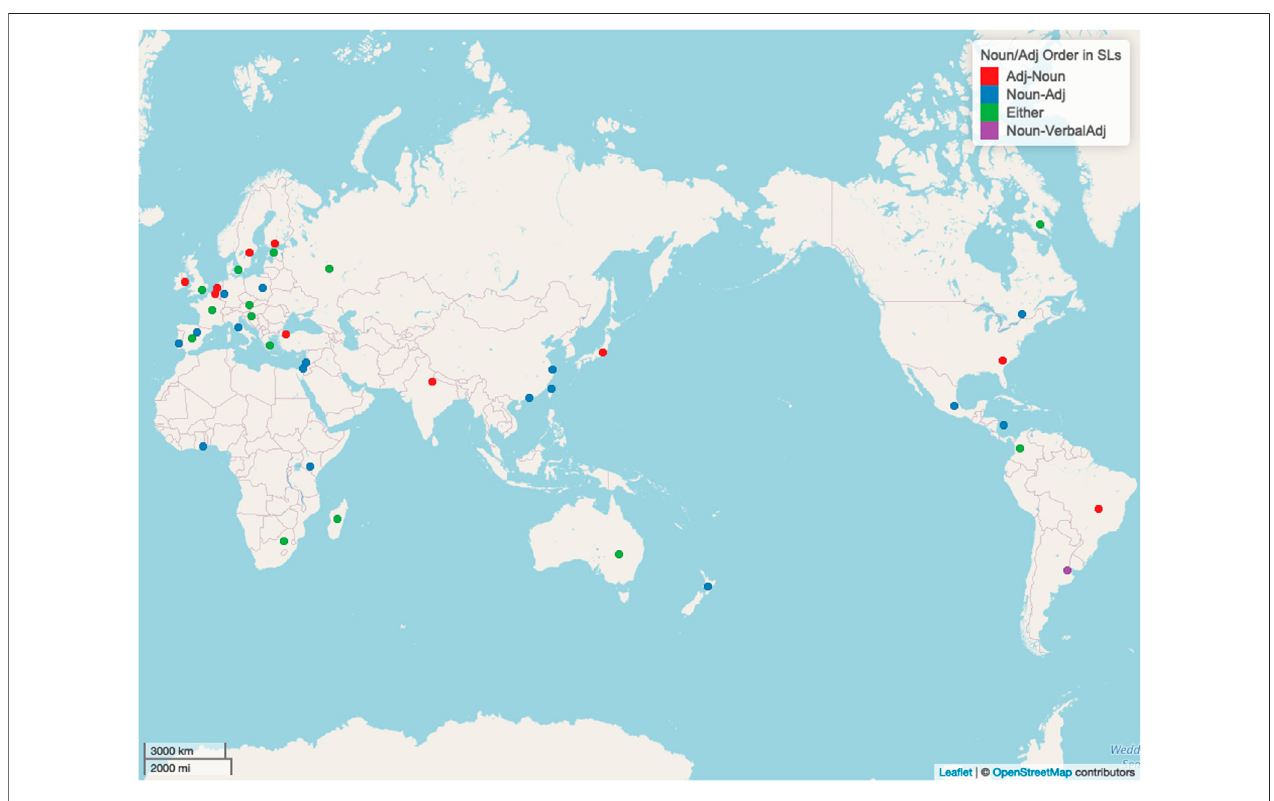
FIGURE 2 | Map of noun/adjective order in sign languages.